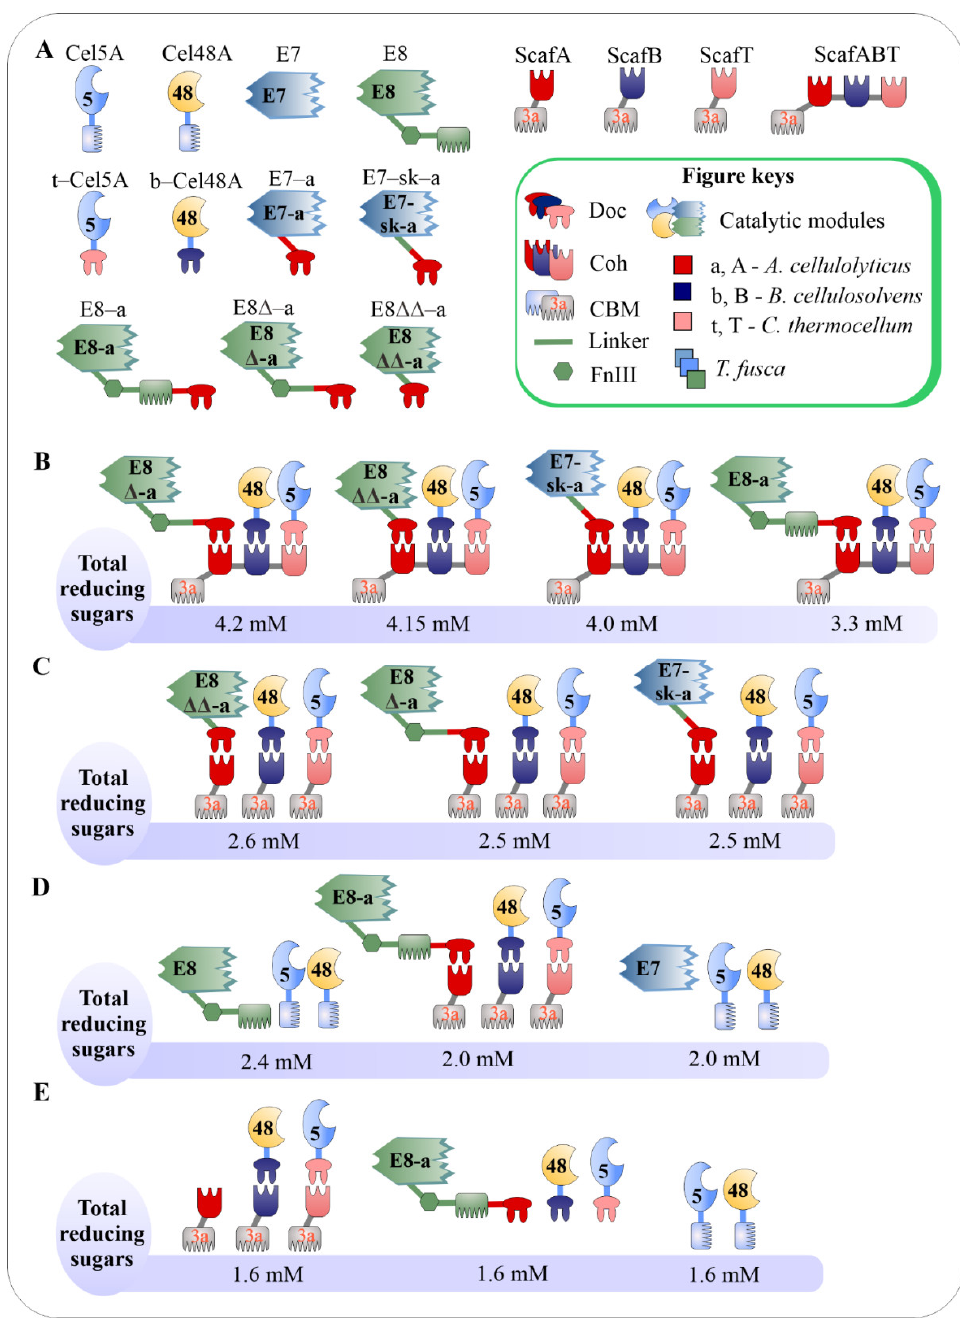
Figure 3. Hydrolysis of cellulose by LPMO-bearing DCs. ( A ) The WT form of Cel5A, Cel48A, E7, E8 and the converted enzyme variants t–Cel5A, b–Cel48A, E7–a, E7–sk–a, E8–a, E8Δ–a, and E8ΔΔ–a. ( B ) The trivalent DCs with E7 and E8 variants exhibit the highest enzymatic activities. ( C ) The mix- tures of chimeric individual enzymes also possess potent hydrolytic activities. ( D ) The mixtures of WT E8, E7, Cel5A, and Cel48A showed average activities. ( E ) Without LPMO in the enzyme mix- tures, the capability of cellulose conversion was dramatically